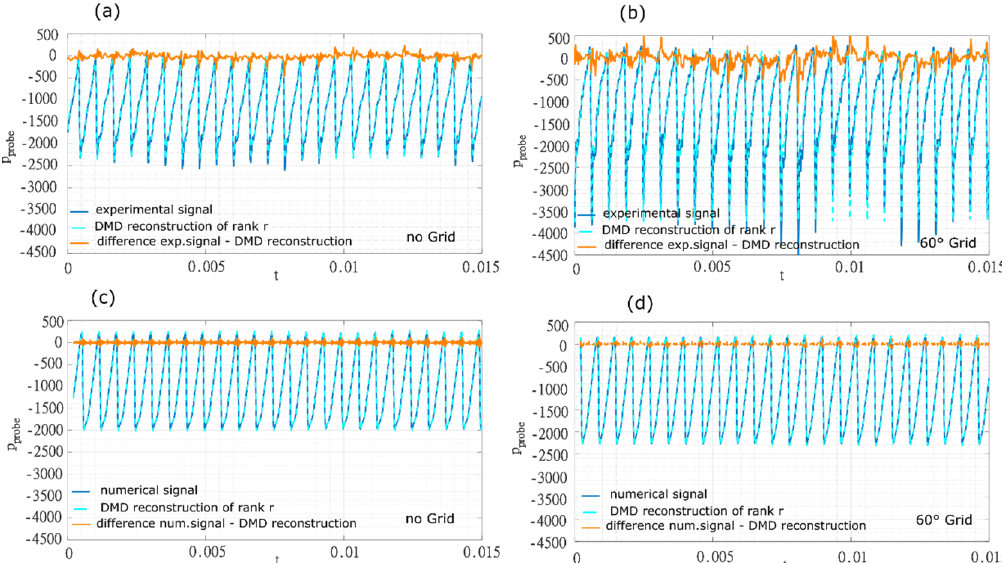
Figure 4. ( a,b ) Comparison between raw signal (blue) and DMD reconstruction (light blue) for the case of 5 kg/s; ( c,d ) comparison between raw numerical signal (blue) and DMD reconstruction (light blue) for the case of 4.85 kg/s. Difference between raw signal and DMD reconstruction plotted in orange.